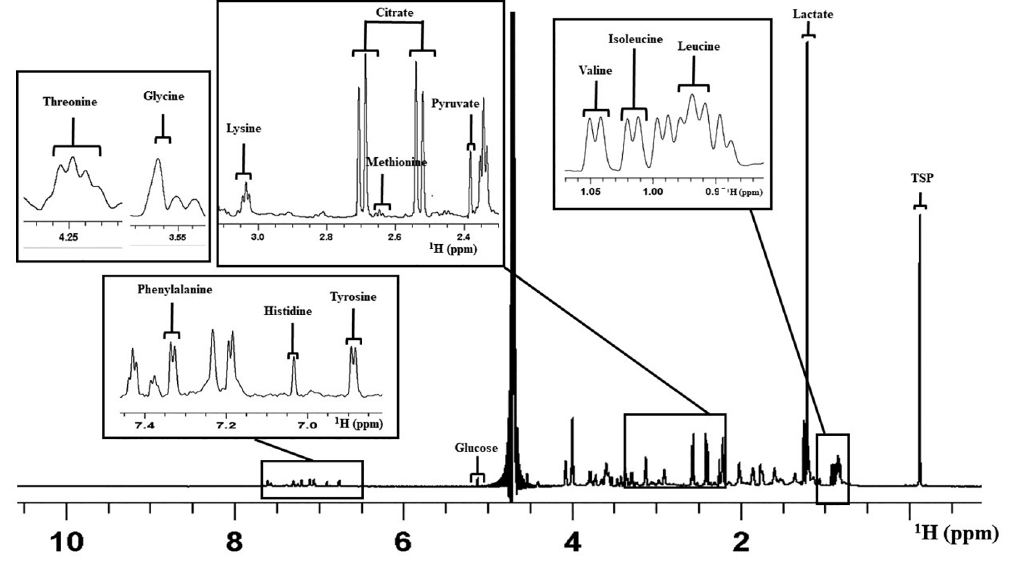
Figure 2. Representative figure for one dimensional 1 H NMR spectrum of the ONESTEP embryo culture medium used in this study. The figure represents the assignment of peaks for different medium constituents. X-axis represents the chemical shift in parts per million (ppm). NMR=nuclear magnetic